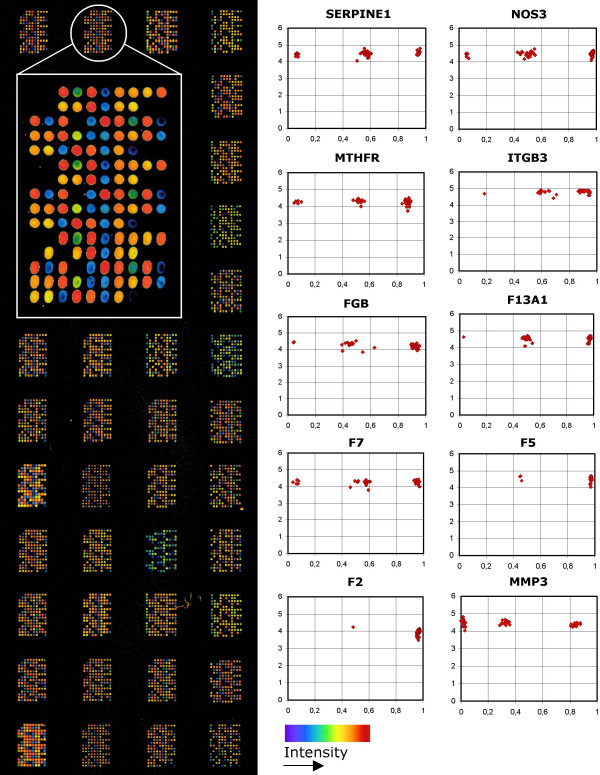
An array-of-microarrays and the corresponding clusters. 48 subarrays are spotted to each glass each having the entire set of 40 anti-tags spotted in triplicates (left panel insert) thus constituting an array-of-arrays (left panel). The colors are artificially added according to signal intensity by the software. The two signals for each SNP are plotted together as cluster diagrams where the three clusters represent each of the three possible genotypes (right panel). Allelic fractions (AFs, x-axes) are calculated from the signal intensities as spot 1/(spot 1 + spot 2) and logarithm of the total signal is used for the y-axes. To investigate the variability between tag sequences, each allele-specific extension primer was designed with two alternative tag sequences. All combinations for each SNP gave similar clusters to the presented.